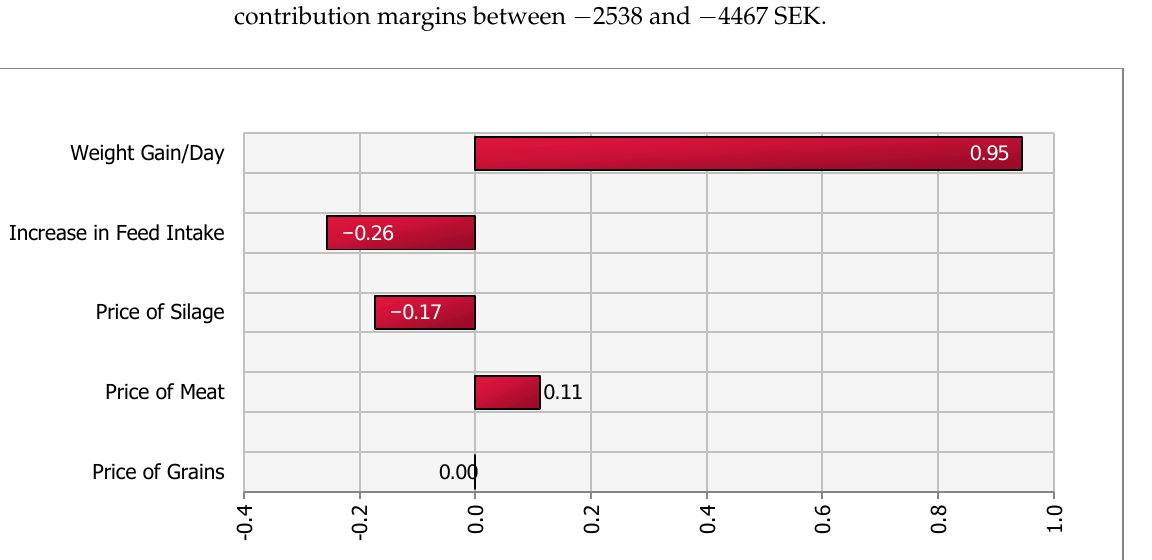
Table 4. Effects a of an increase in space allowance (from 2.2 to 2.7 m 2 /calf)—Scenario 2a.